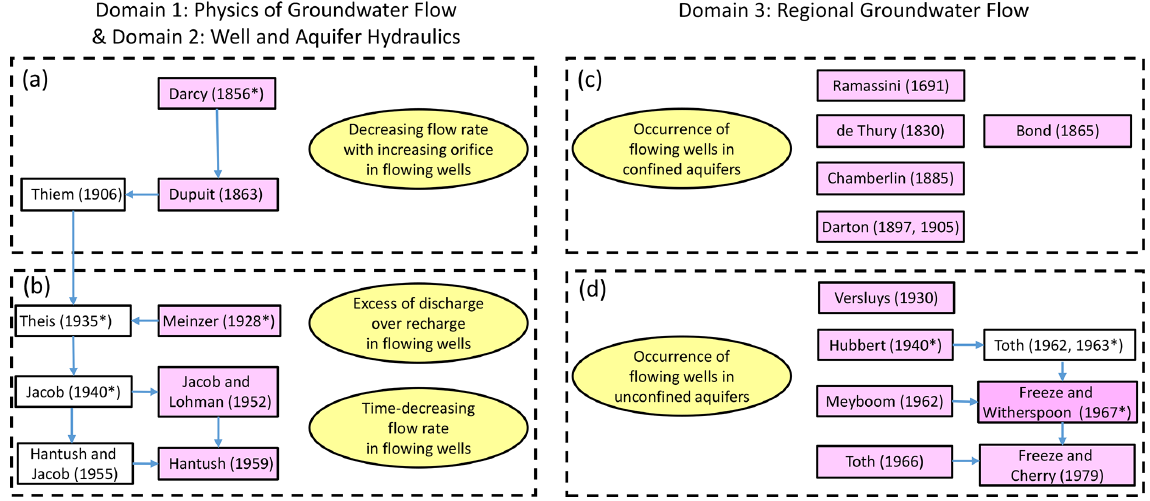
Figure 1. Four threads of evolution of physical hydrogeology stemmed from flowing wells. The yellow ellipses are field phenomena of flowing wells, the purple boxes are papers directly related to flowing wells, and the white boxes are papers less or not directly related to flowing wells but have connections to previous or follow-up studies on flowing wells. The publications labeled with a “ ∗ ” are the seven classical studies identified by both Freeze and Back (1983) and Anderson